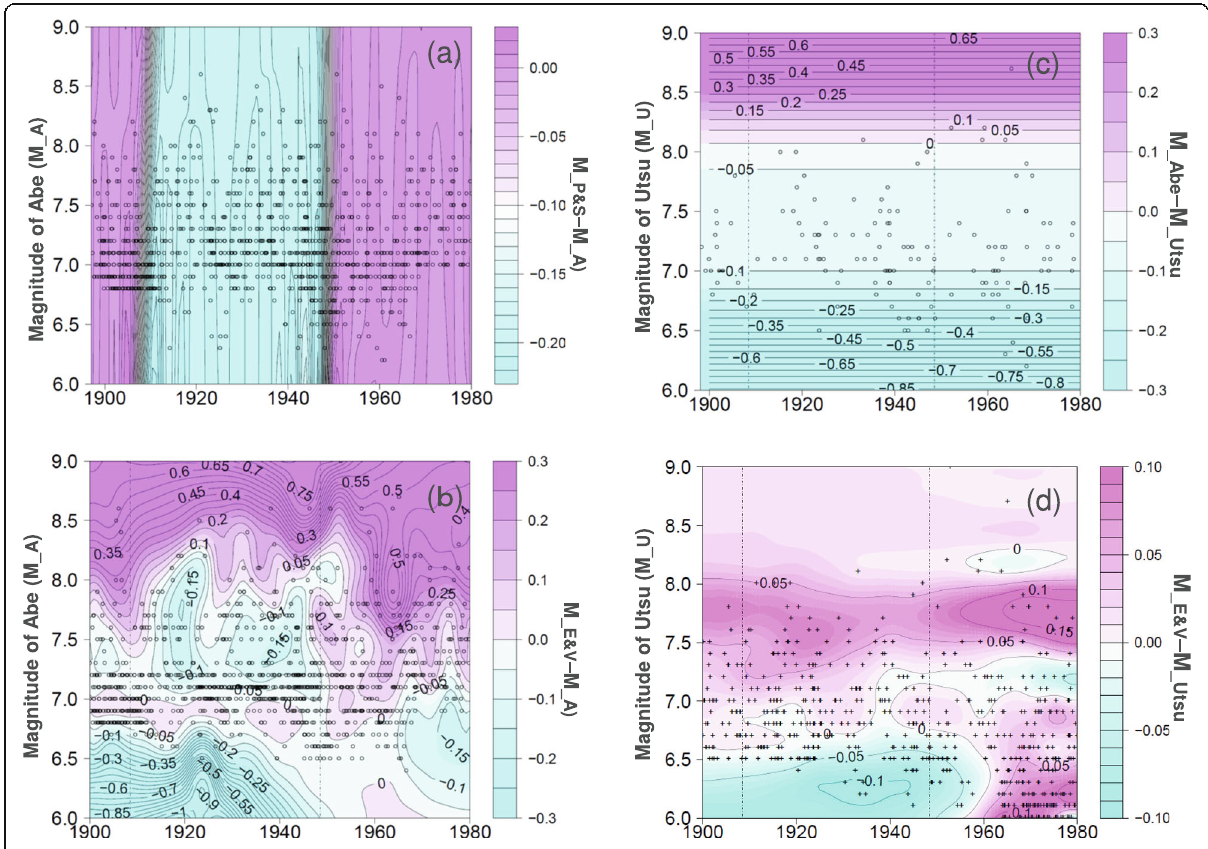
Fig. 6 Smoothed surfaces of magnitude differences of P&S and E&V catalogs against Abe catalog. a M P&S – M ABE , b M E&V – M ABE on the plane M ABE against the elapsed time (1897 – 1980) for global earthquakes, c M ABE – M UTSU , and d M E&V – M UTSU on the plane M UTSU over the period in years for Japan region. High magnitude differences are shown in purple (in contrast to than light blue). The vertical dotted lines in a – d denote 1922 and